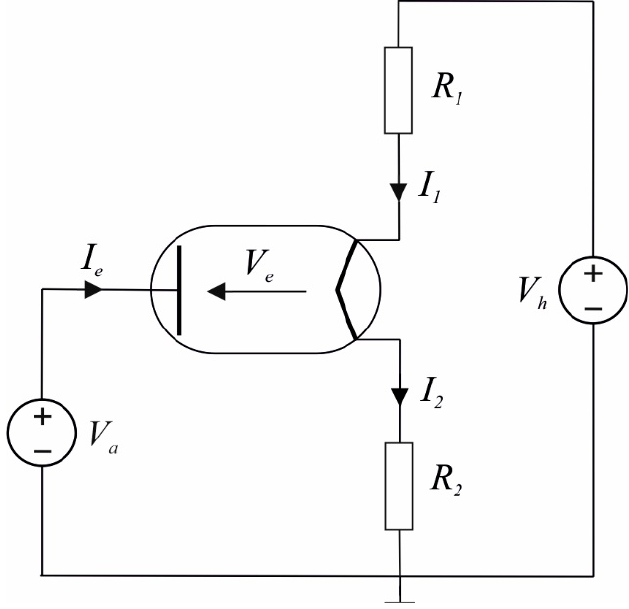
Figure 2. A simplified scheme of the I e - V conversion circuit.